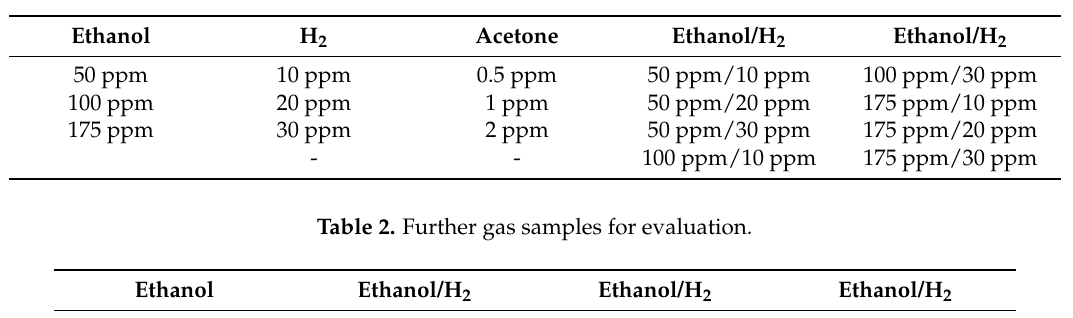
Table 1. Gas samples for calibration.